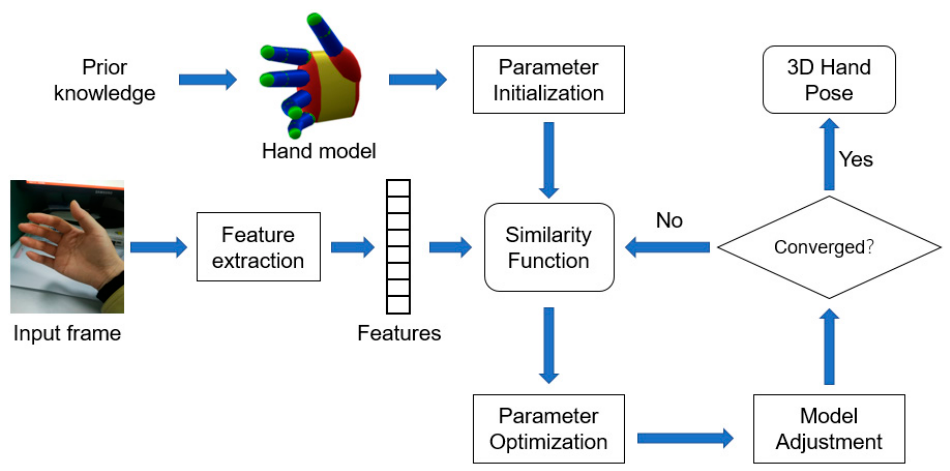
Figure 6. The workflow of generative methods for hand pose estimation.